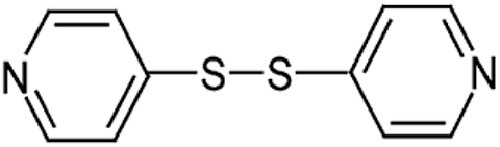
Structural formula of 4,4′-dithiodipyridine (DTDP) (adapted from [1]).